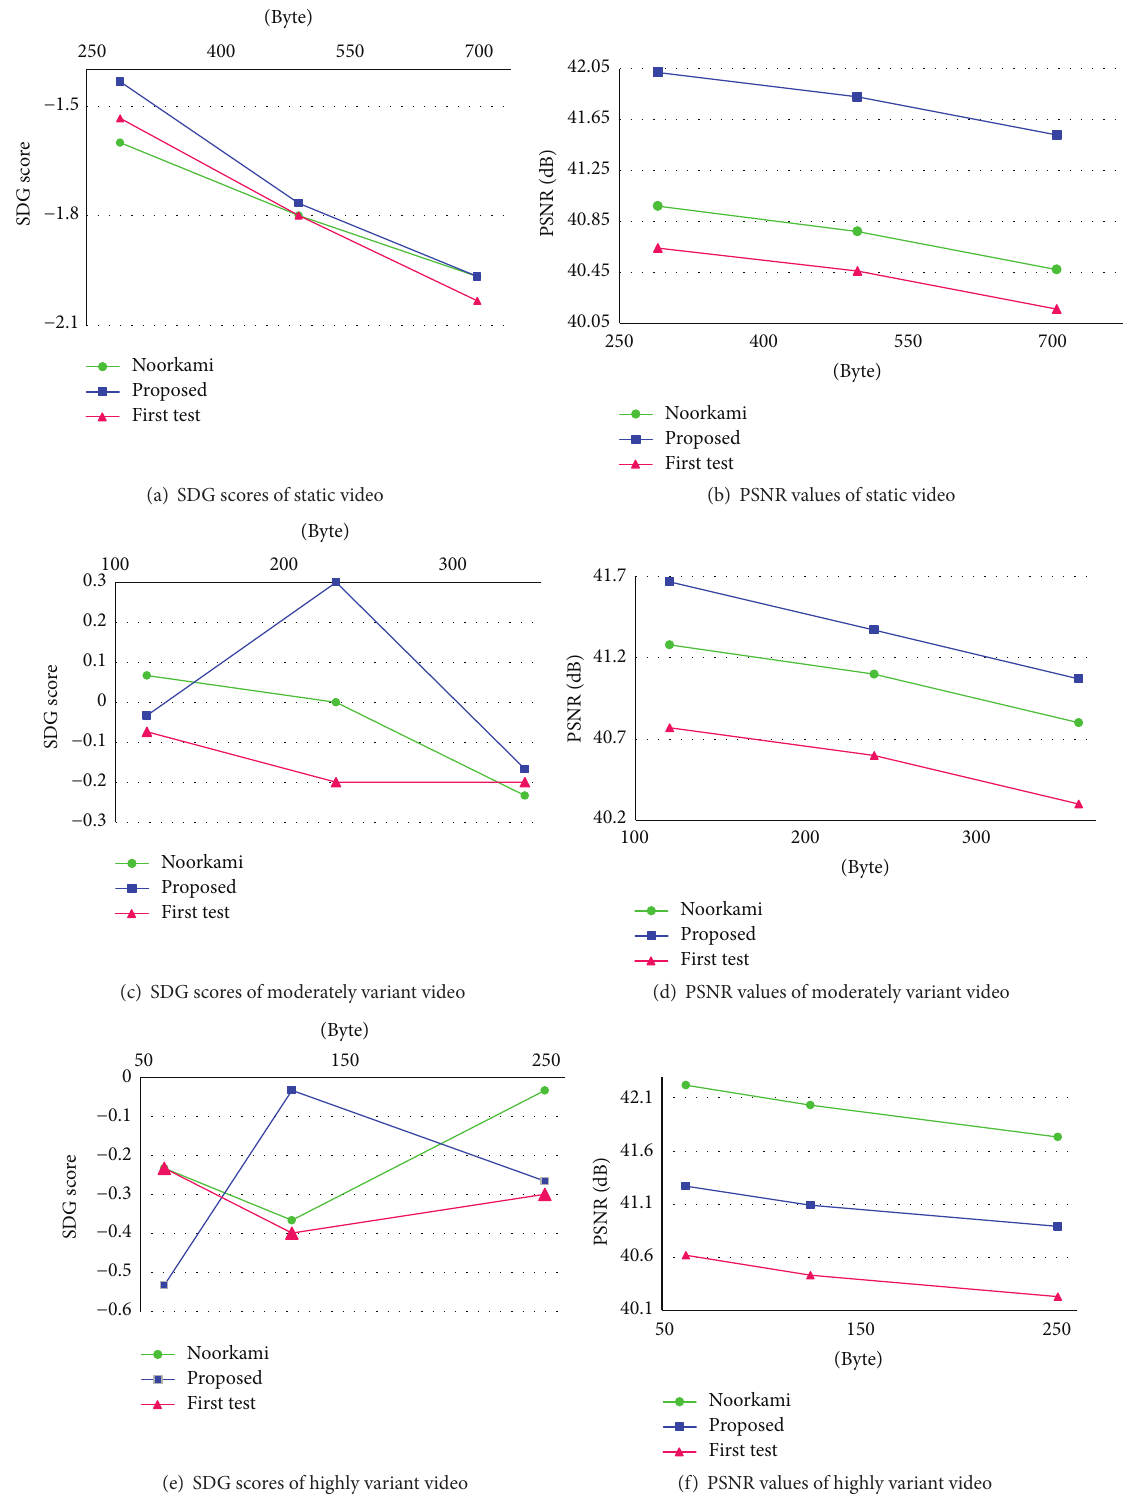
Figure 4: SDG scores and PSNR values achieved with the first test, proposed algorithm, and